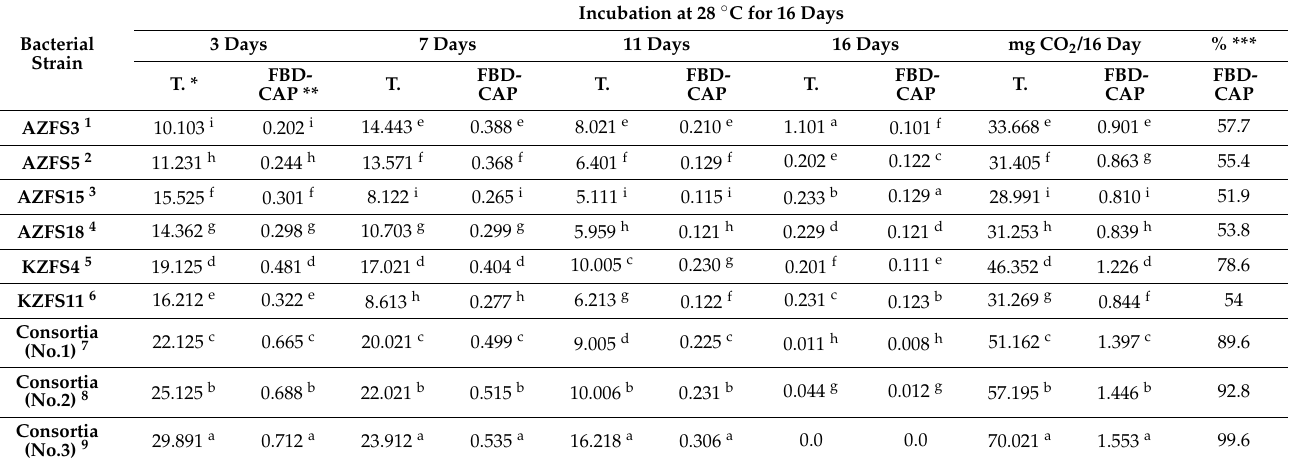
Table 5. Carbon dioxide evaluation (mg CO 2 /100 g.d. wt. soil.) from sandy loam soil treated with FBD-CAP mixture at (10 mg/kg) as affected by inoculation with the highest microbial active pesticide